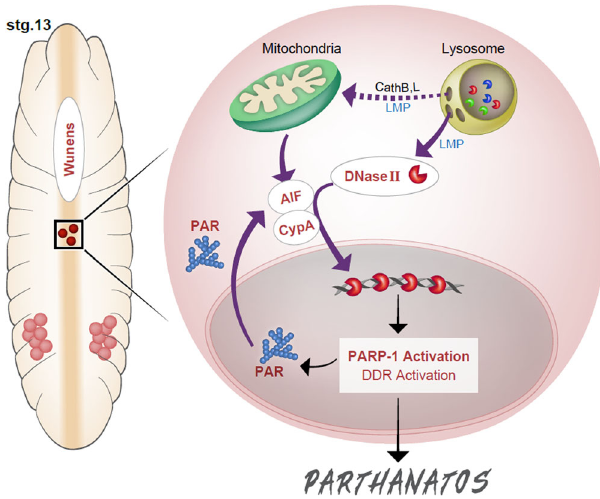
Fig. 10 An integrated model of the developmental form of PGC death by parthanatos. An illustration of an embryo at ES 13 (left) and an enlargement of a dying PGC (right), featuring the molecular model of PGC death. Purple arrows indicate translocations from one cellular compartment to another, while black arrows indicate signaling. PGCs that remain in the midline experience high somatic Wunens (LPP) activity, which may induce LMP and the release of lysosomal hydrolases, including DNase II, CathB and CathL (See the Discussion for more details about a possible link between the Wunens and LMP). The release of CathB, L from the lysosomes might promote the initial release of AIF from the mitochondria as was reported 100 (dashed arrow). AIF then, together with CypA, promotes the translocation of DNase II to the nucleus, presumably as a CypA-AIF-DNase II complex. In the nucleus, DNase II cleaves the DNA, leading to PARP-1 activation, which in turn generates PAR. PAR modi fi es proteins both in and outside the nucleus, activating the DDR and promoting massive release of AIF from the mitochondria, respectively. This positive feedback ampli fi cation loop between DNase II and PARP-1 (mediated by AIF and PAR, respectively), activates the ATR/Chk1 branch of the DDR (presumably to a critical threshold), ultimately leading to PGC